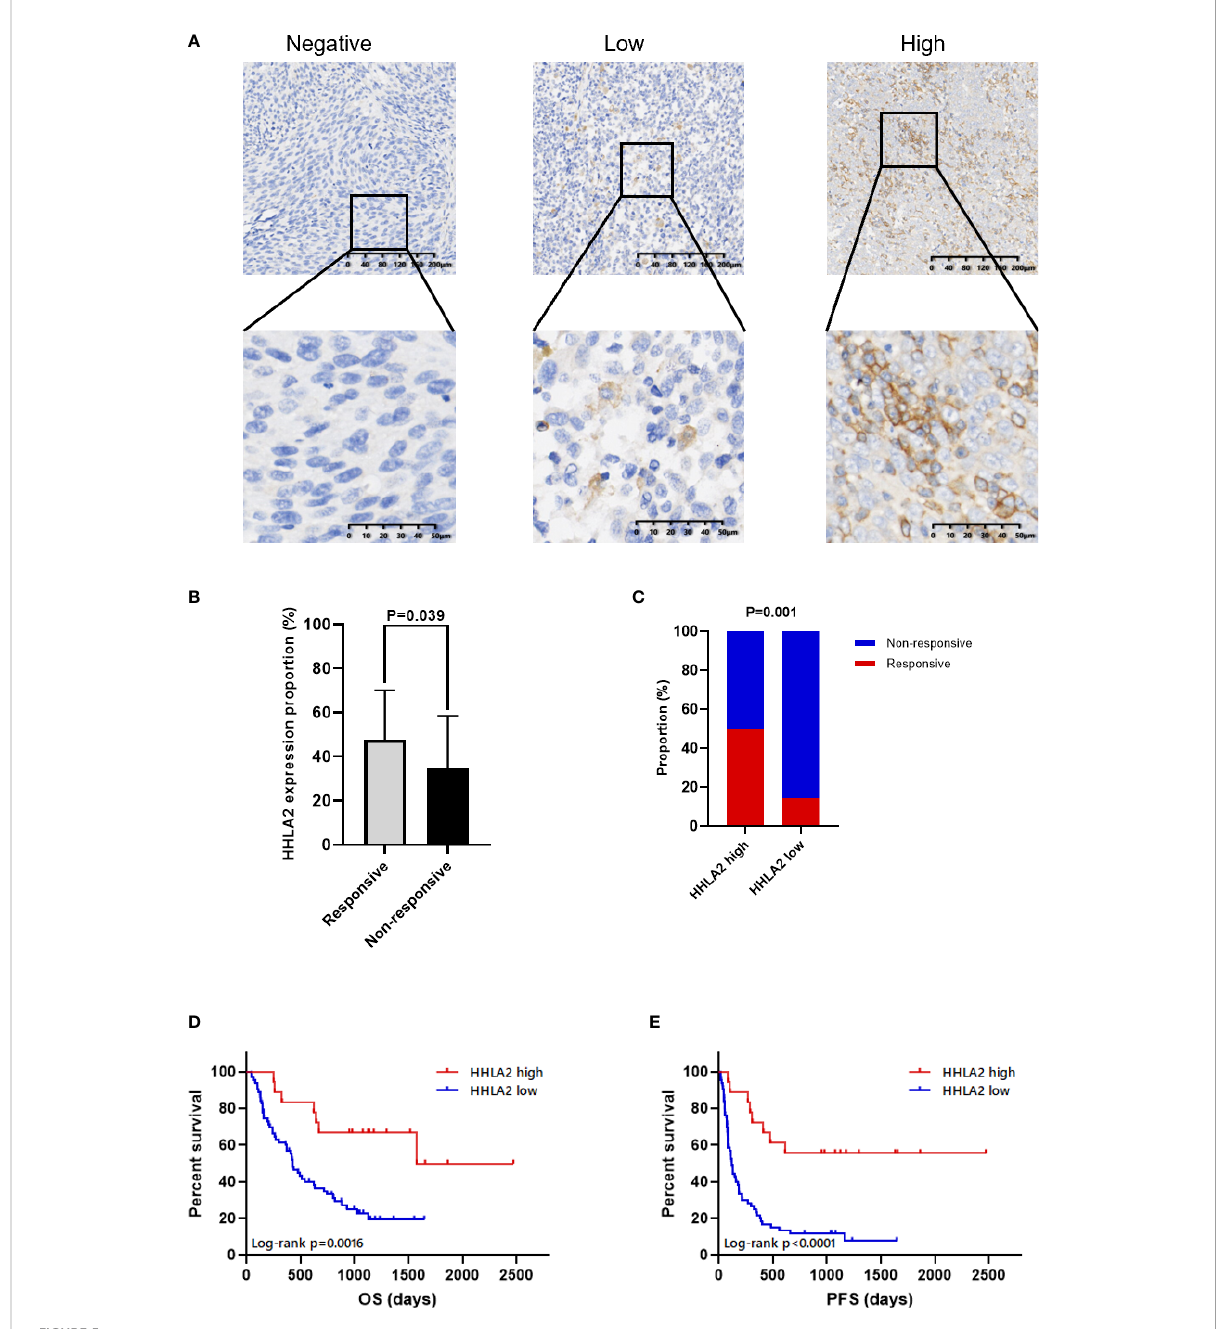
FIGURE 5 The association between HHLA2 expression and response to ICB in patients with melanoma. (A) Representative micrographs of HHLA2 expression in tumor. (B) The proportions of HHLA2 expression in tumor tissues from ICB-treated responders and non-responders (unparalleled t-test, p=0.039). (C) The response rates of ICB-treated patients in high and low HHLA2 expression group ( c 2 test, p=0.001). (D) KM curves illustrated that high HHLA2 expression was associated with improved PFS after ICB therapy. (E) KM curves showed that high HHLA2 expression was related to improved OS after ICB treatment. P values <0.05 are in